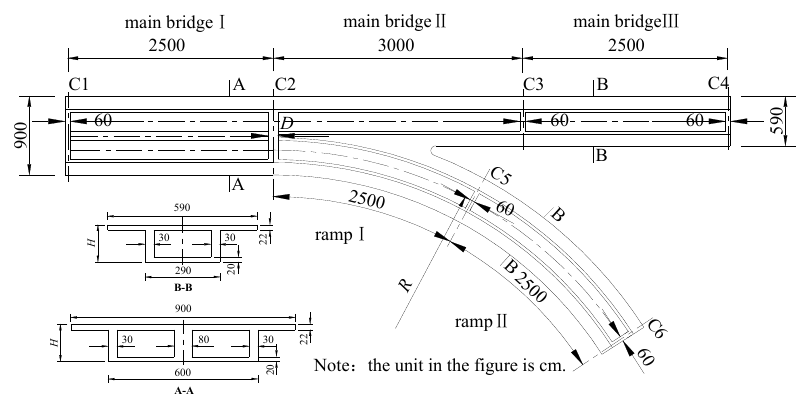
Figure 4. Plan view of a typical irregularly-shaped bridge.